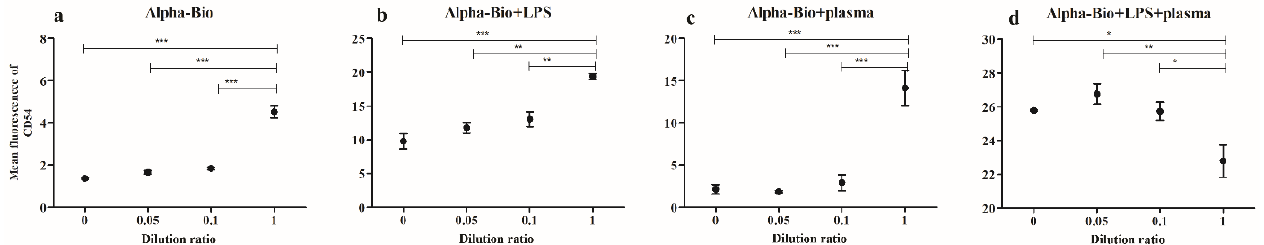
Table 3. Analysis of the expression level of CD54 molecule on the surface of THR-1 cells after 24 h of incubation with NSMP from the Nobel Replace system.